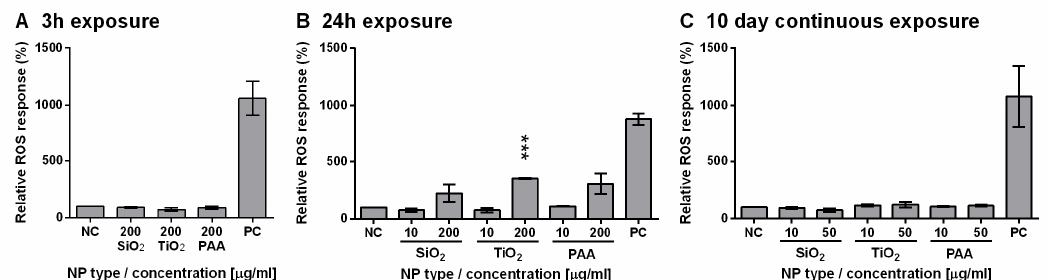
Figure 7. TiO 2 , PAA, and SiO 2 NPs induced reactive oxygen species (ROS) formation in L6 cells in a dose-dependent manner. ROS induction after ( A ) 3 h, ( B ) 24 h, and ( C ) 10-day exposure of rat L6 cells to SiO 2 , TiO 2 , or PAA NPs (10, 50 or 200 µ g / mL). Results are shown as increased compared to the control, which was not exposed to NPs. Mean and standard error are shown (3 h, n = 2; 24 h, n = 2, 10 days, n = 3; n stands for the number of independent experiments, each performed in 3 replicates; PC stands for positive control, 1 mM H 2 O 2 ). Statistical significance is displayed as follows: *** p ≤ 0.001.